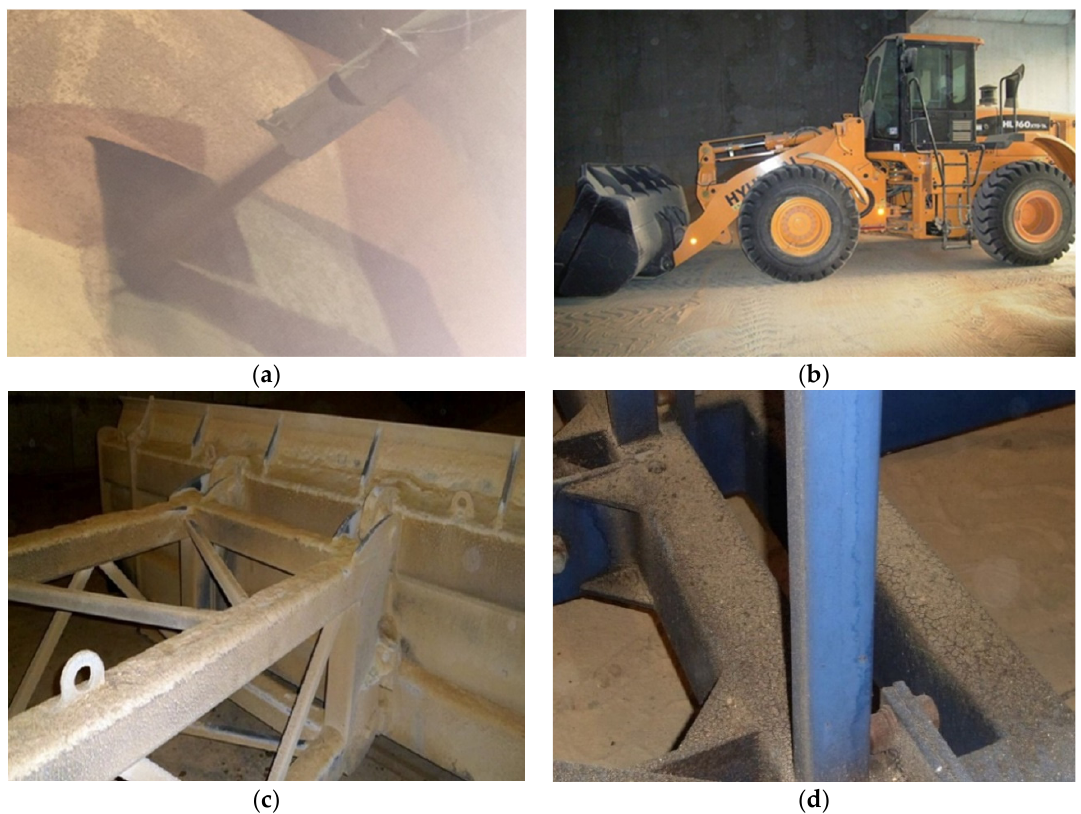
Figure 1. Examples of emission ( a ) and deposition of powdery fraction of seed meal on the floor of a warehouse ( c ) and machinery parts ( b , d ) (original photos by J. Chmiel, J. Halska).